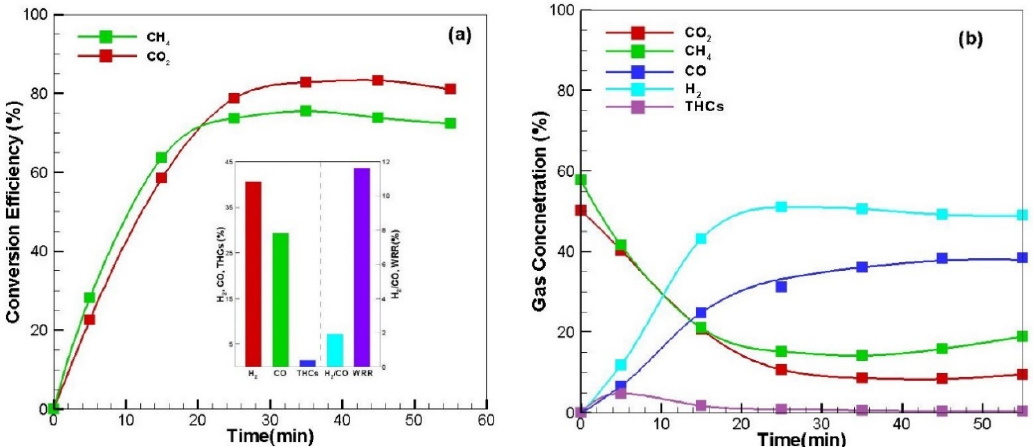
Figure 3. Characteristics of biogas reforming. ( a ) CH 4 and CO 2 conversion efficiencies, H 2 /CO ratio, weight reduction rate (WRR), product gas average concentration and ( b ) product gas concentration over time.